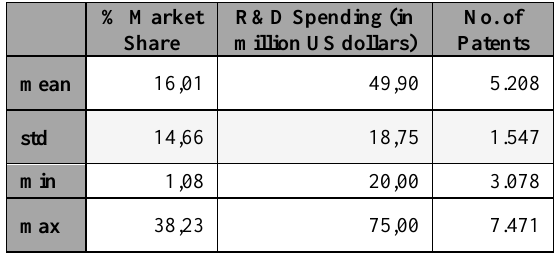
Table 4: Nokia Descriptive Statistics